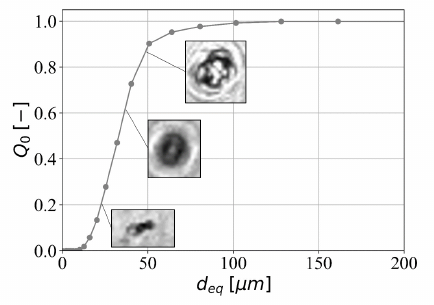
Figure 4. Size-dependent AP for M3_2PP.